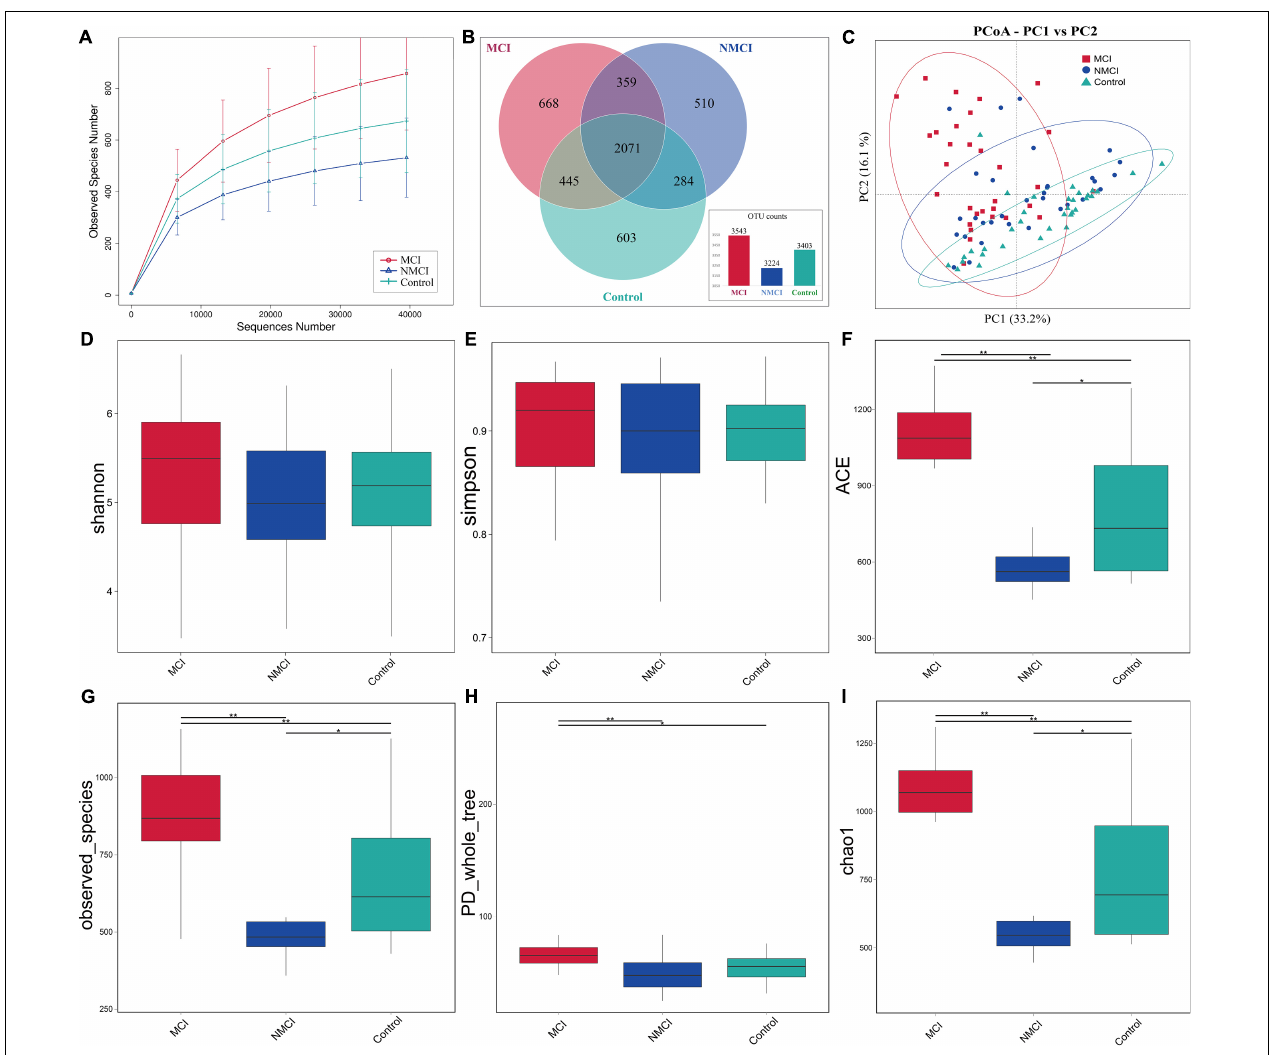
FIGURE 1 | Comparison of the intestinal microbiota richness and diversity among three groups. (A) Rarefaction curve showed the number of identified OTUs approached a plateau, indicated that the sequencing depth is enough for analysis. (B) Venn diagram showing the shared and unique OTUs. (C) PCoA based on weighted UniFrac distance was used to analyze the structure of intestinal flora among three groups (Anosim, p < 0.01): each dot represents a sample, and different colors and shapes indicate the group to which they belong. The result is shown along the first and second axes of the PCoA plot. Numbers in parentheses represent explained variation. Ellipses represent different groups. Shannon (D) , Simpson (E) , ACE (F) , observed_Species (G) , PD_whole_tree (H) , and Chao1 (I) indexes were used to assess alpha diversity. MCI, hypertension patients with cognitive impairment, NMCI, hypertension patients without cognitive impairment; Control, health control